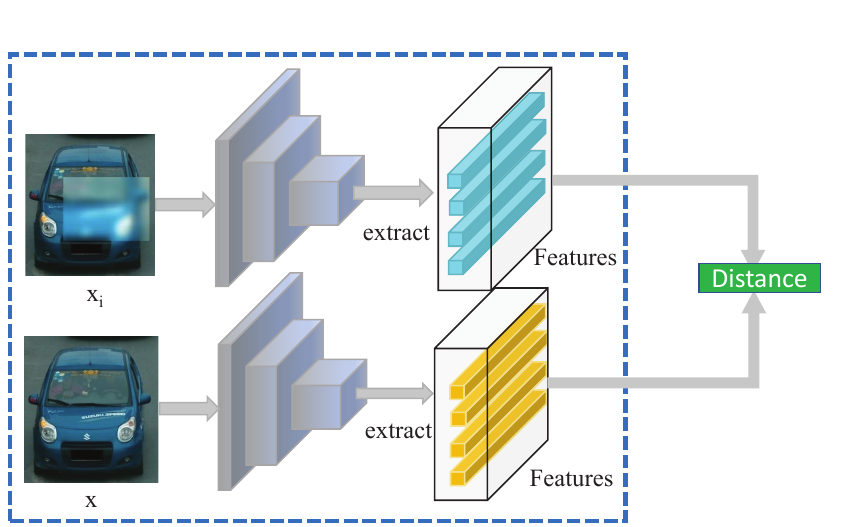
Figure 5. Overview of feature distances. The augmented images x 1 , x 2 , x 3 , and x 4 compare the dis- tances with the original image x